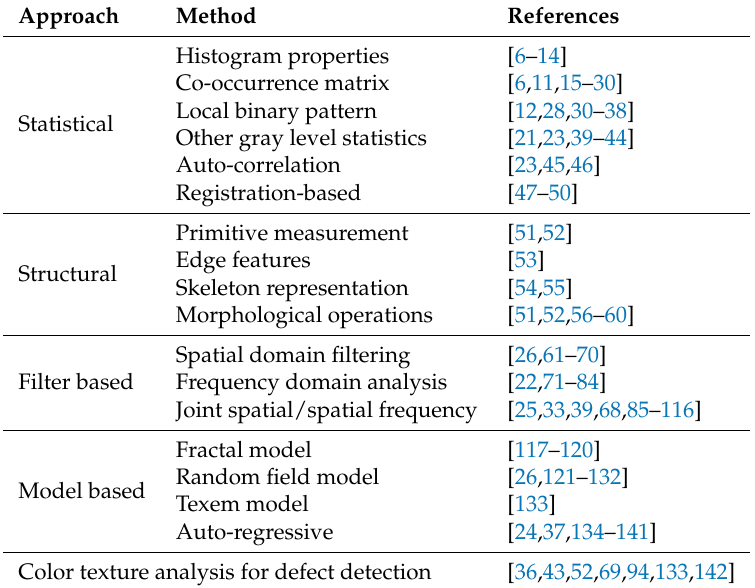
Table 2. A selection of most commonly used textural defect detection